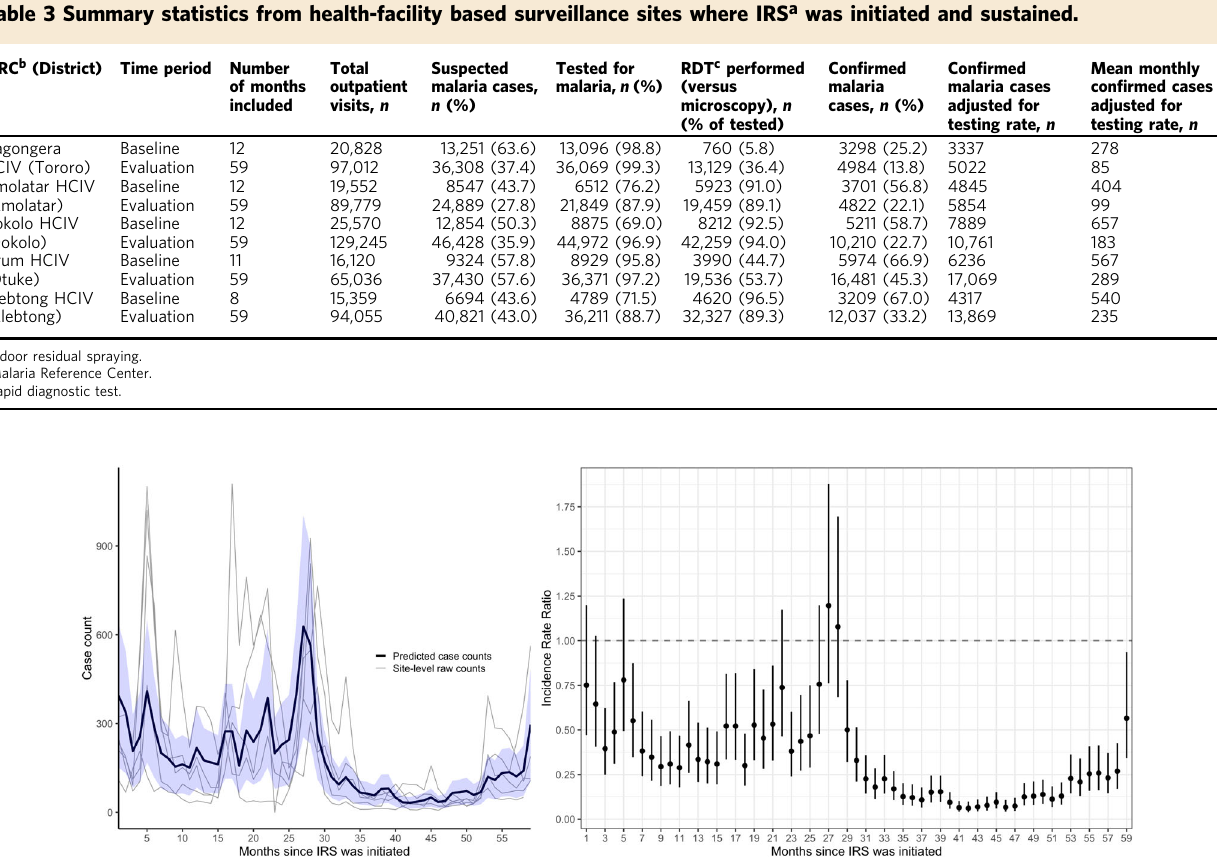
Fig. 5 Predicted case counts and adjusted incidence rate ratios (IRR) from multilevel negative binomial model assessing the impact of initiating and sustaining indoor residual spraying (IRS). The blue shaded region on the left represents the 95% con fi dence interval around the mean predicted case counts across sites from the adjusted regression model. Gray lines represent observed monthly case counts from individual sites. On the right, vertical bars represent the 95% con fi dence interval around the adjusted IRR (the measure of center for the error bars).